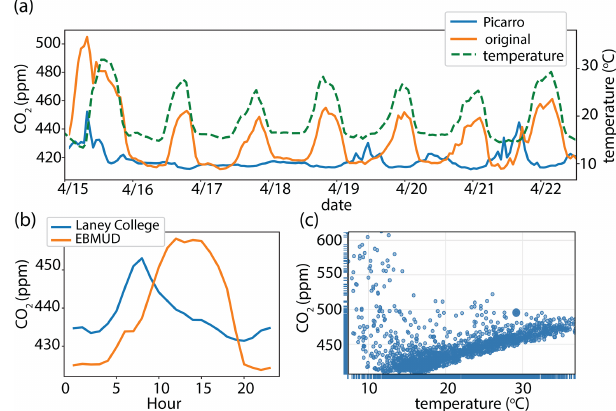
Figure 2. (a) CO 2 mixing ratios from April 2020 at EBMUD and measured with a Picarro instrument at the Richmond Field Station supersite. (b) EBMUD 2020 diurnal cycle compared with Laney College. (c) Temperature dependence of the CO 2 signal at